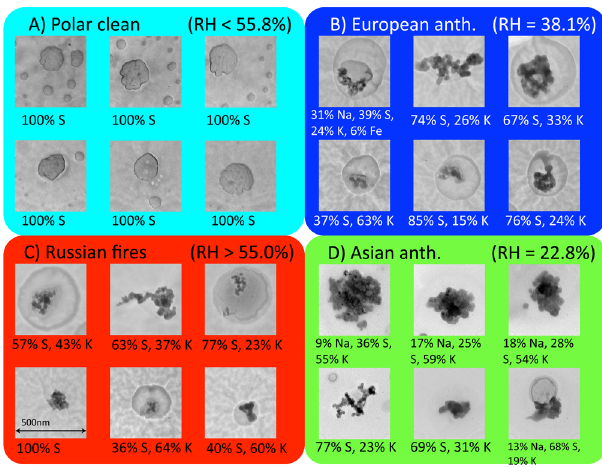
Fig. 13. Representative images of submicron aerosol particles sam- pled in situ during POLARCAT flights. Particle origins are: polar clean air (A) , European anthropogenic (B) , Russian fires (C) and Asian anthropogenic (D) . Width of images corresponds to 500nm. Elemental compositions of particles, determined by EDX, are indi- cated in term of atomic ratio (C, N, O are excluded). See text for